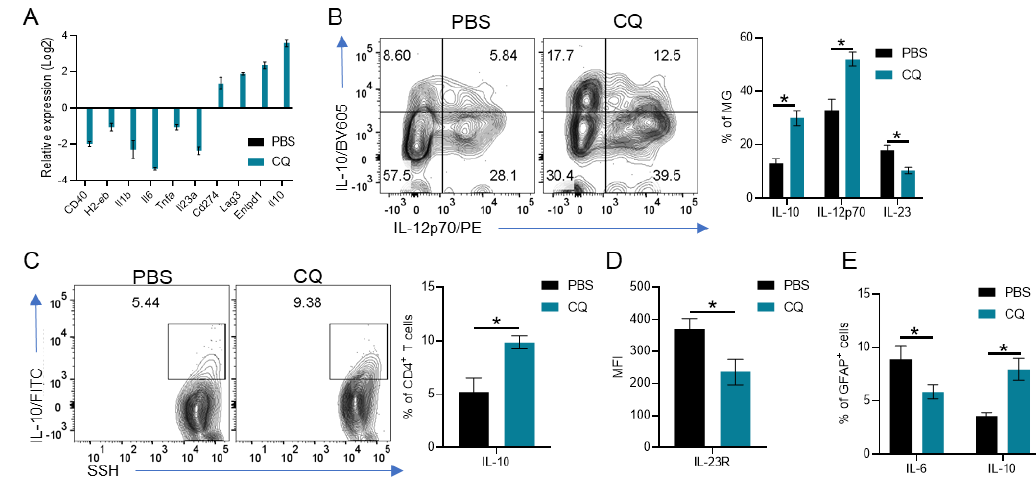
Figure 4. CQ-treated MG modulates T cells and astrocytes. Primary MG were activated with LPS (100 ng / mL) in the presence or absence of CQ (50 µ M) for 18 h. ( A ) Gene expression analysis in CQ-treated MG compared with PBS-treated ones. ( B ) Analysis of IL-10, IL-12p70 and IL-23 production by MG. ( C ) MG were co-cultured with CD4 + T cells and the production of IL-10 was analyzed by flow cytometry. ( D ) IL-23R in CD4 + T cells cultured with MG. ( E) MG were cultured with C8D30 astrocytic cells and the production of IL-6 and IL-10 was analyzed by flow cytometry. Cultures were carried out in triplicate. Values of p < 0.05 (*) were considered statistically significative. Results from three independent experiments.